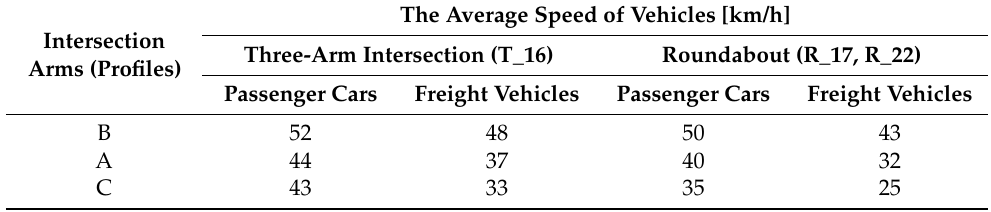
Table 6. Average driving speeds of cars and trucks on the intersection arms (profiles A, B, and C) of intersections in Žilina